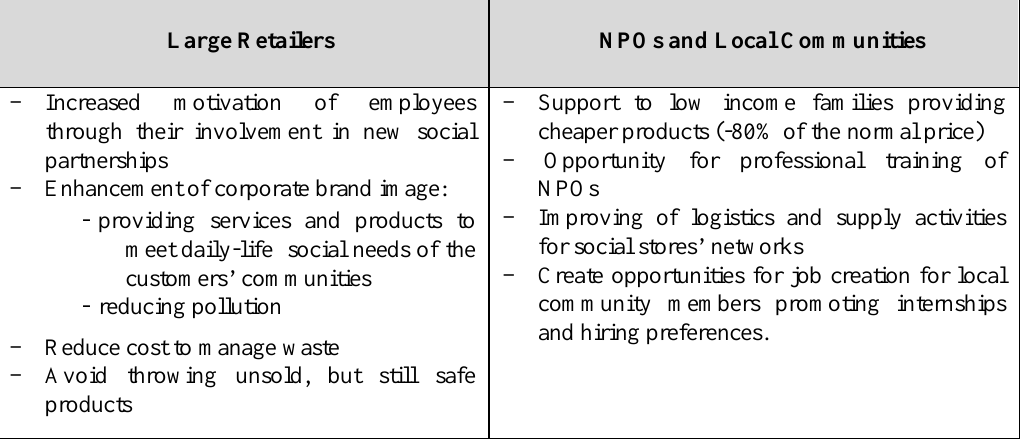
Large Retailers NPOs and Local